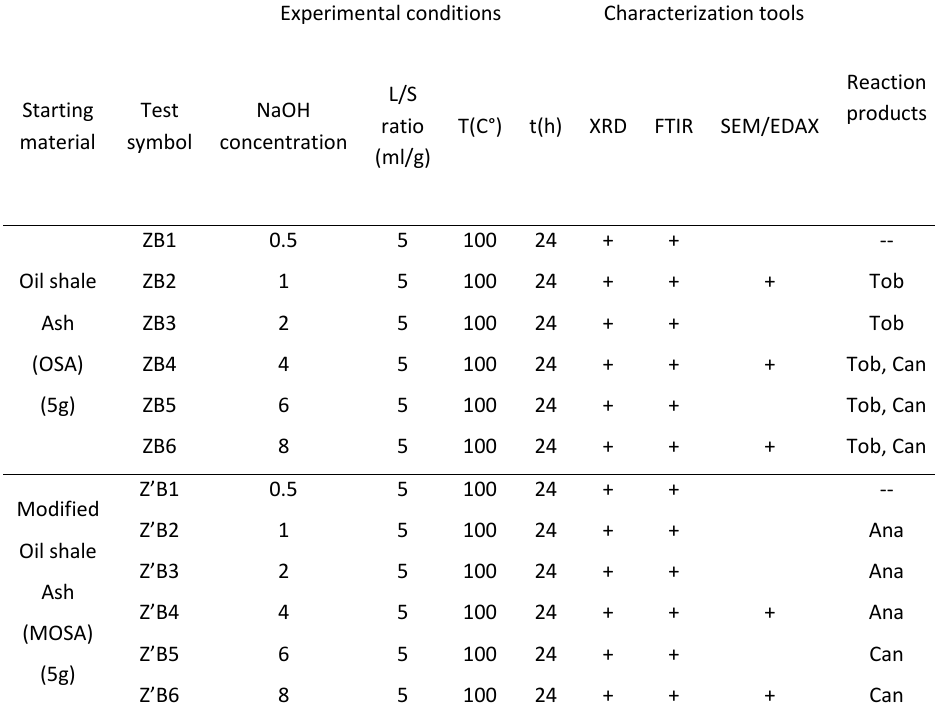
Table 2. Experimental conditions and characterization tools employed in the alkali activation of the oil shale ash (OSA) and the modified oil shale